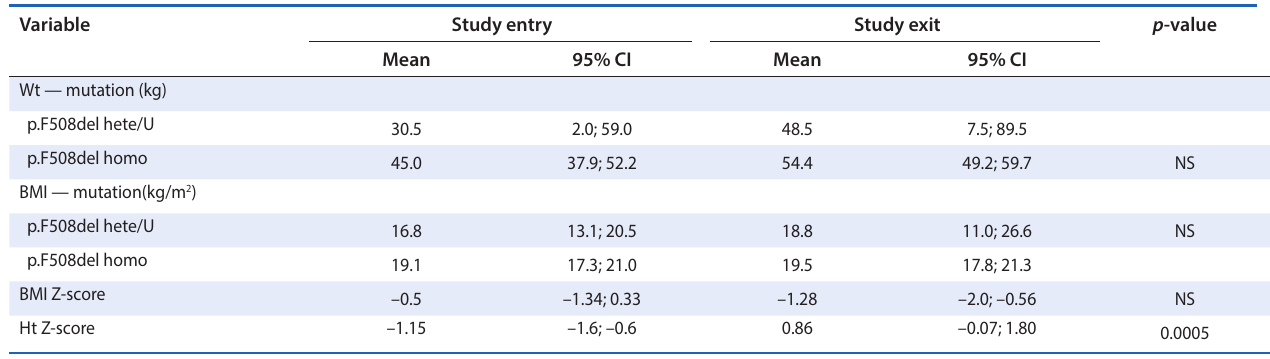
Notes: CI = confidence intervals; Wt = weight in kilograms; Ht = height in centimetres; BMI = body mass index; p.F508del hete/U = p.F508del heterozygous and unidentified mutations; p.F508del homo = p.F508del homozygous; NS: not statistically significant. Table 3: Comparison of lung function between mutation and gender